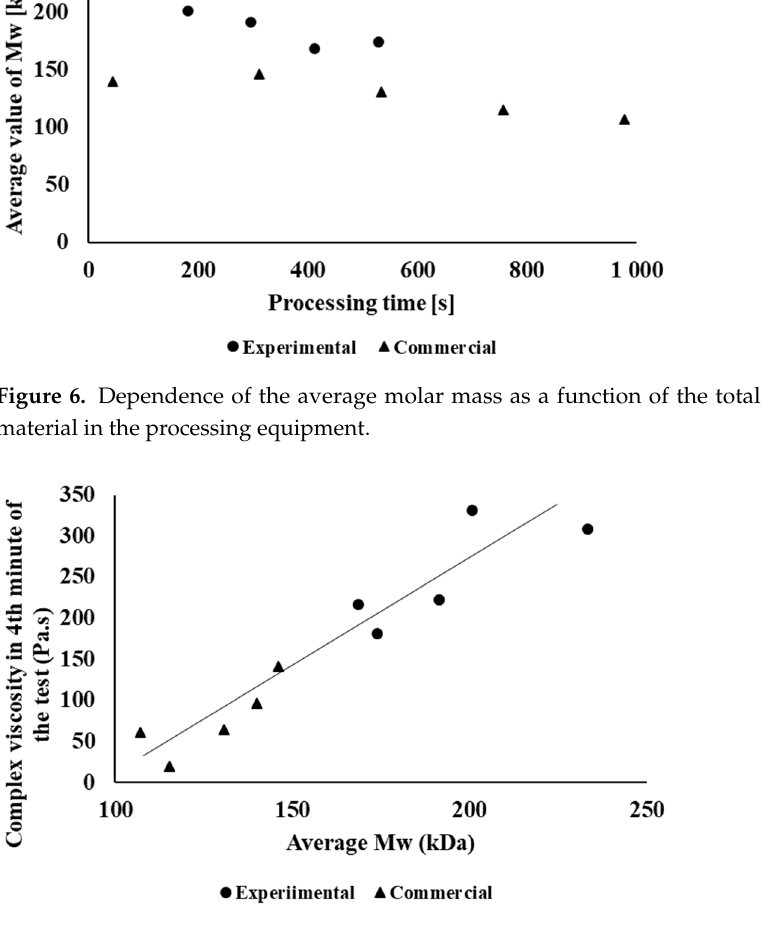
Figure 7. Dependence of complex viscosity in the 4th minute of the processing stability test on the average molar mass of the material.